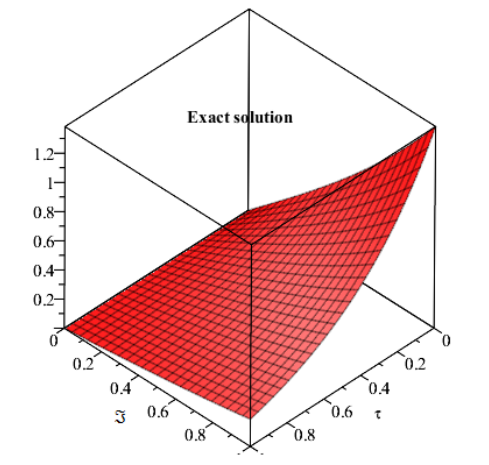
Figure 12. Exact solution of Example 4 at β = 2.